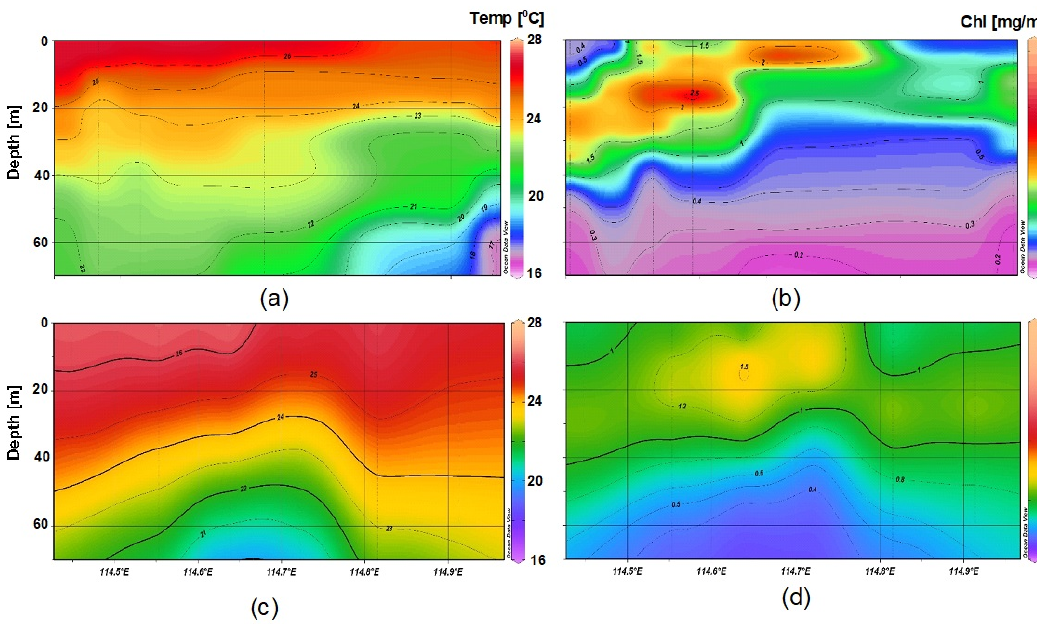
Figure 1. Depth profile observed on July 2012; ( a ) Sea Surface Temperature (SST) (°C) during Indian Ocean Dipole (IOD) (+); ( b ) SSC during IOD (+); and observed on August 2013; ( c ) SST (°C) during IOD ( ‐ ); ( d ) Sea Surface Chlorophyll (SSC) during IOD ( ‐ ) in the Bali Strait.